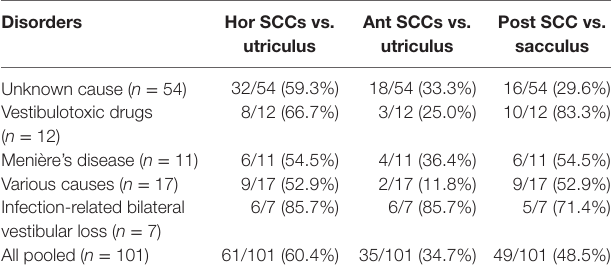
TaBle 7 | Comparison of semicircular canal (SCC) and otolith function according to the vestibular anatomy—percentage of cases that match in function for various disorders.